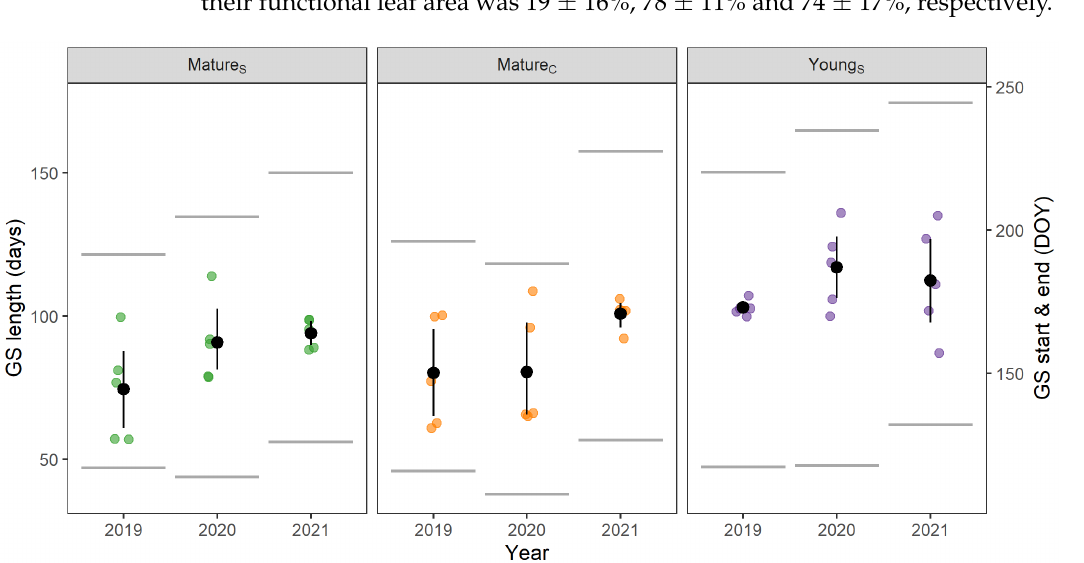
Figure 2. Mean growing season (GS) length (black points) with confidence intervals (black vertical error bars) and mean start and end of GS (lower and upper horizontal lines, respectively) for three studied tree groups during the years 2019 – 2021. Young solitary (YOUNG S ) trees finished their GS later and had a longer GS compared to both MATURE S and MATURE C groups. In 2021, the start and end of the GS was on average shifted to later days of the year (DOYs). See also Figure S2.